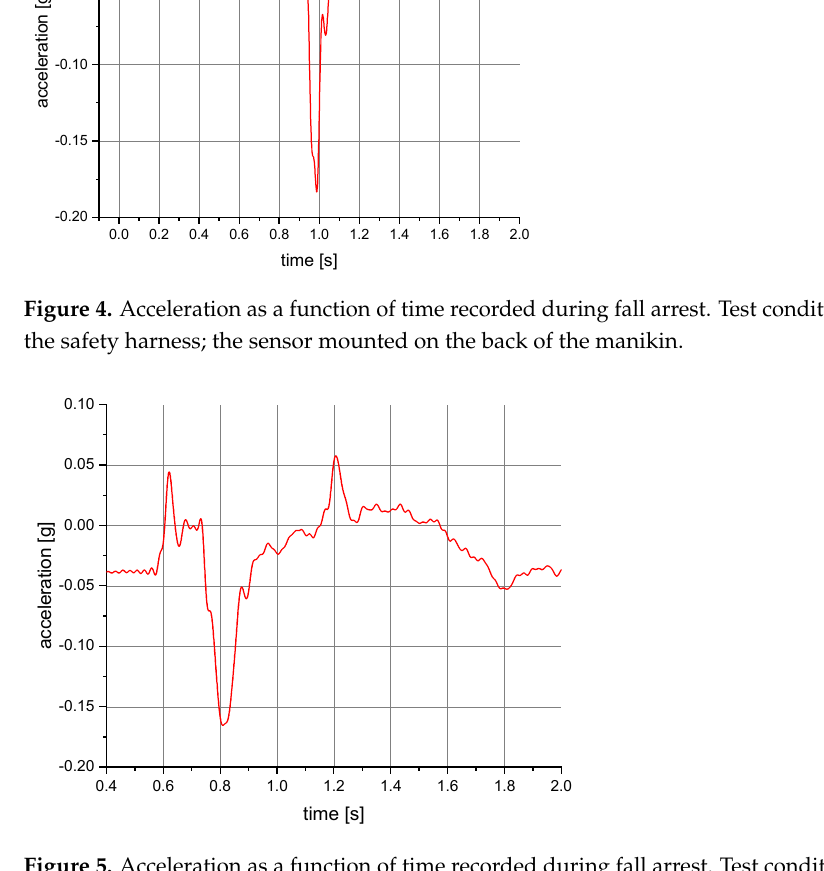
Figure 5. Acceleration as a function of time recorded during fall arrest. Test conditions: back point of the safety harness; the sensor mounted on the abdomen of the manikin.